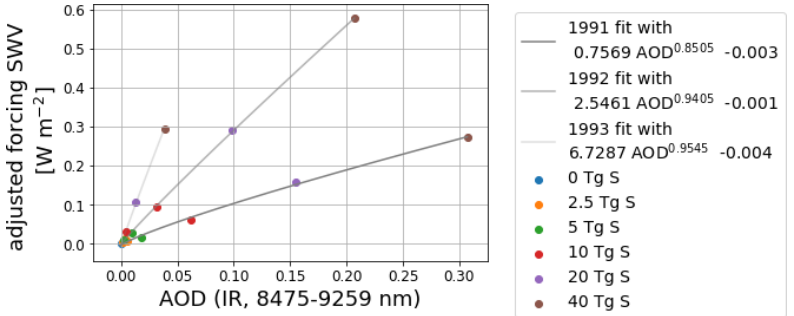
Figure 14. Yearly averages of adjusted forcing due to the additional SWV as a function of AOD (IR, 8475–9259nm) for the 3 examined years (1991–1993). A power function fit for each year with a corresponding equation is shown.